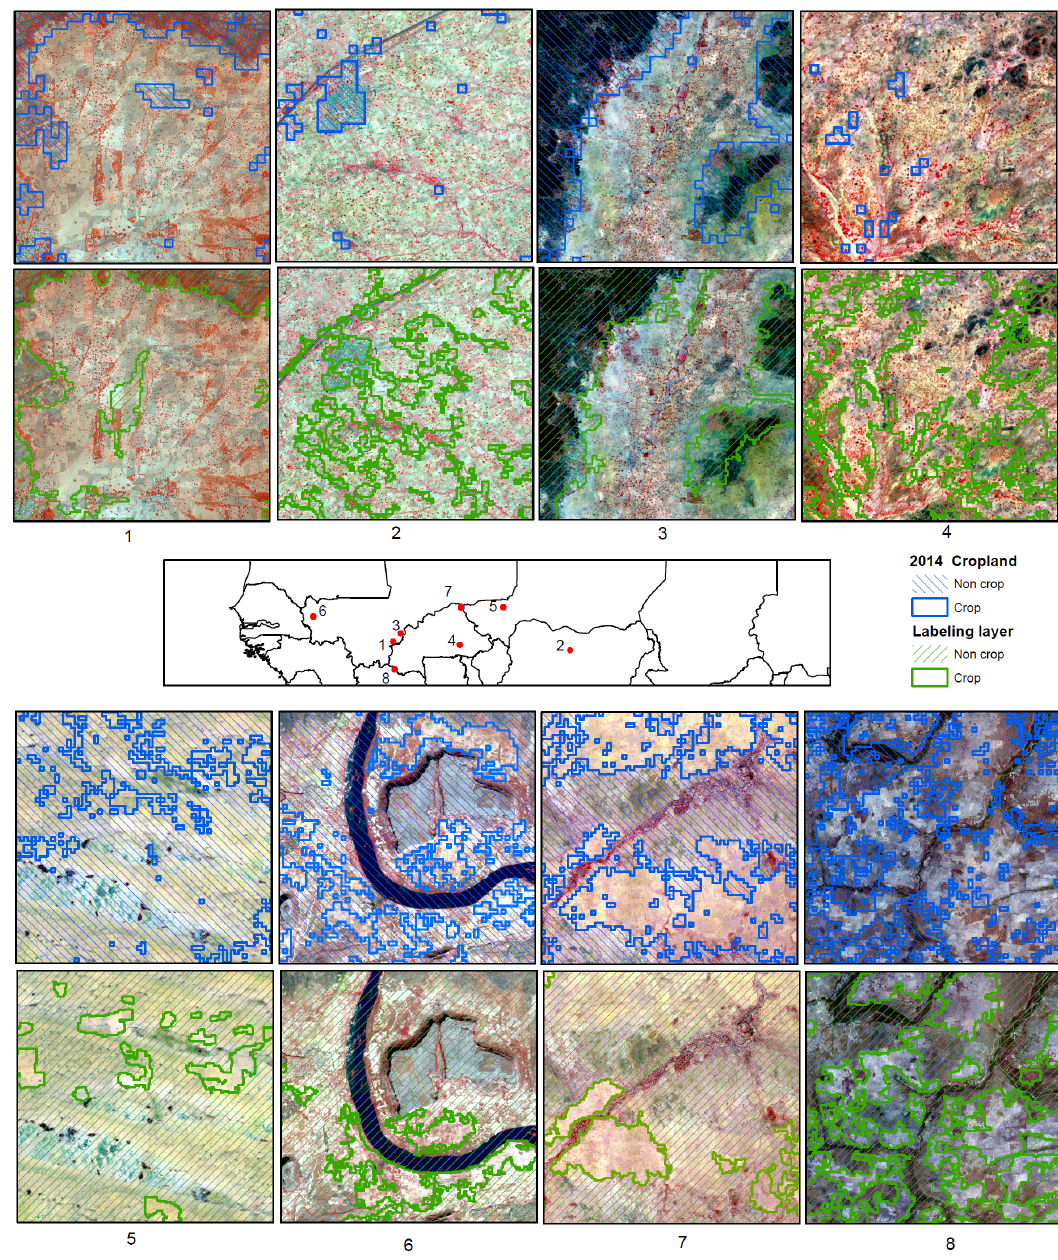
Figure 11. Some examples of cropland in the 2014 Sudano-Sahelian Cropland map (at 100-m) and the labeling layer (at 30-m). Background images are: (1) World View 2 of 26 June 2014; (2) GeoEye of 14 June 2014; (3–7) Spot 5 of the 2013 season; and (8) RapidEye of 29 January